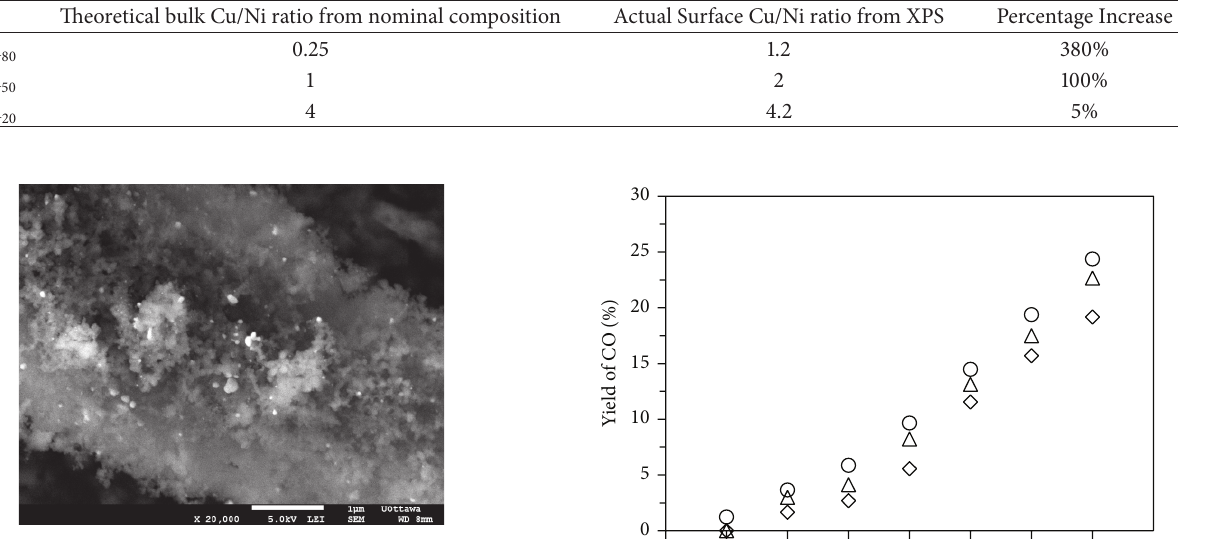
Figure 2: SEM image of a Cu 50 Ni 50 /C catalyst.